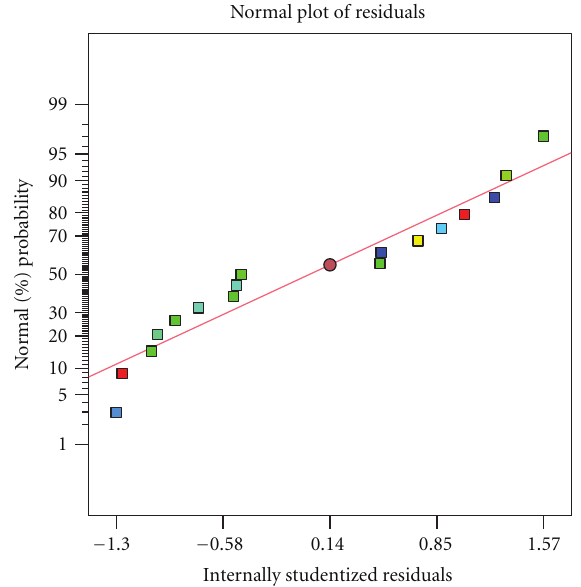
Figure 4: The normal probability (%) plot of the experimental results for % Cr(VI)